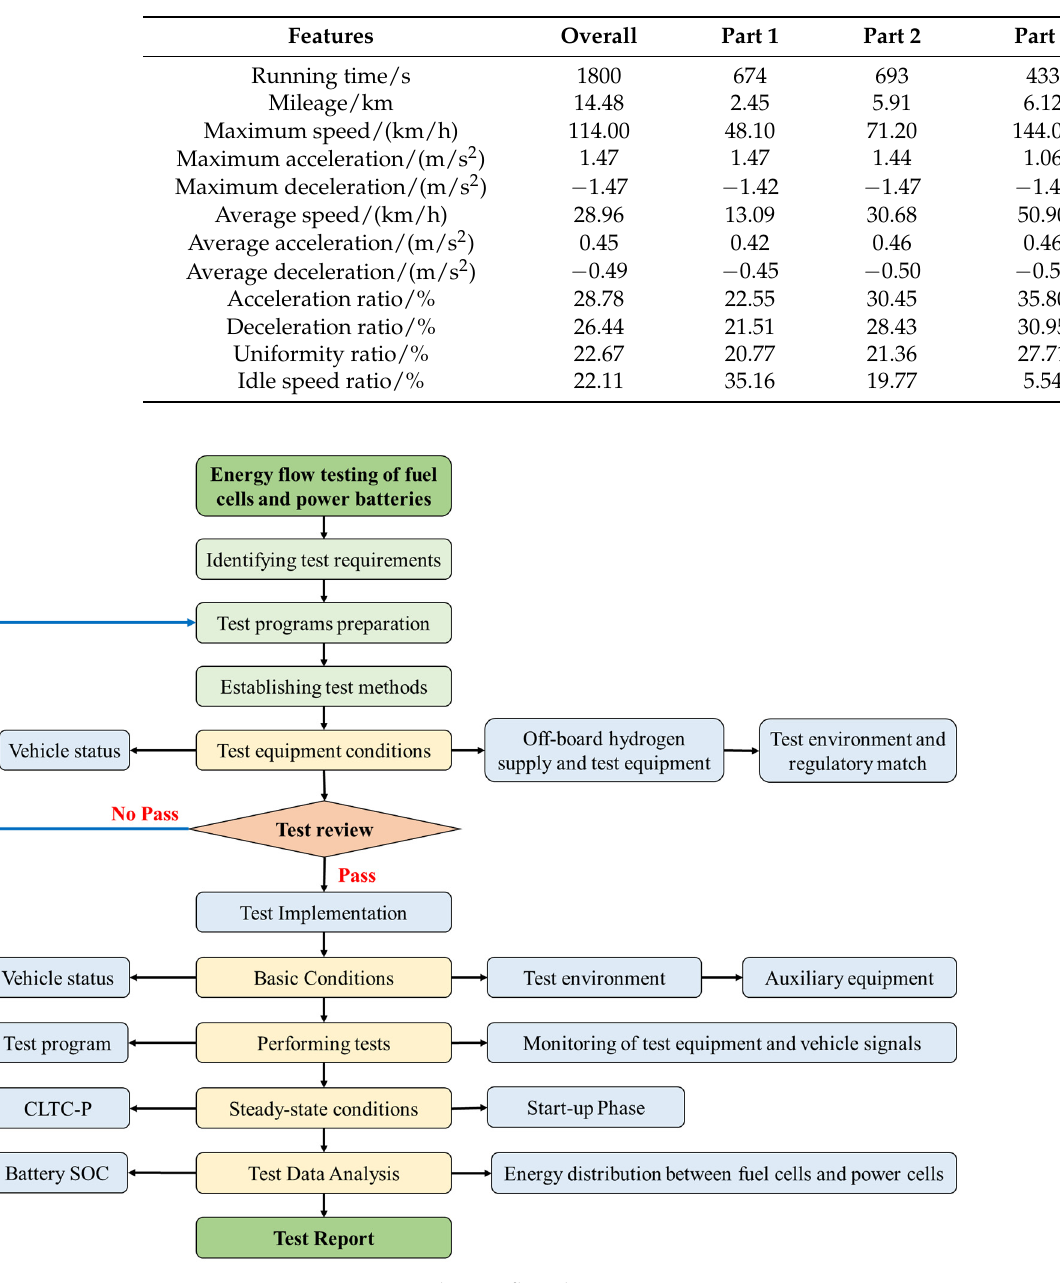
Figure 5. The test flowchart.